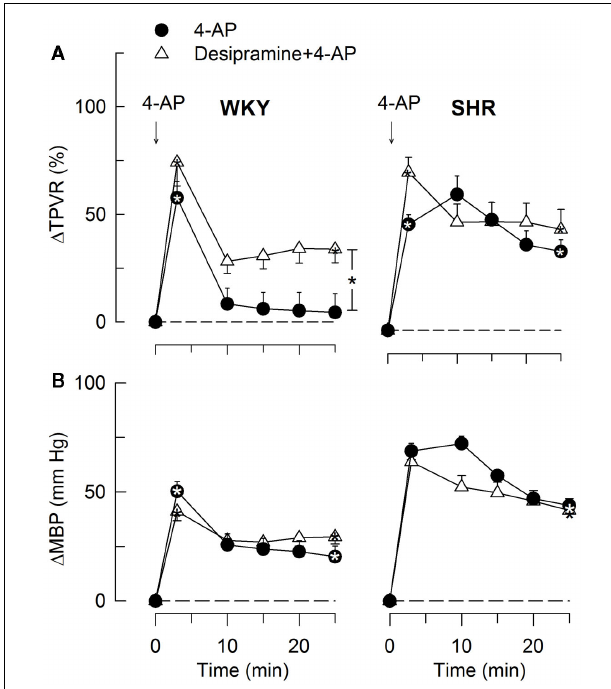
FIGURE 12 |TheTPVR- (A) and MBP- (B) response to 4-AP after inhibition of norepinephrine reuptake with desipramine. Significant responses (* within symbol) and group differences during the immediate TPVR max (none detected) and after 25min (brackets right of curve) were located as indicated. Desipramine reduced baselineTPVR in both strains and also MBP inWKY ( Table 2 ). * – P ≤